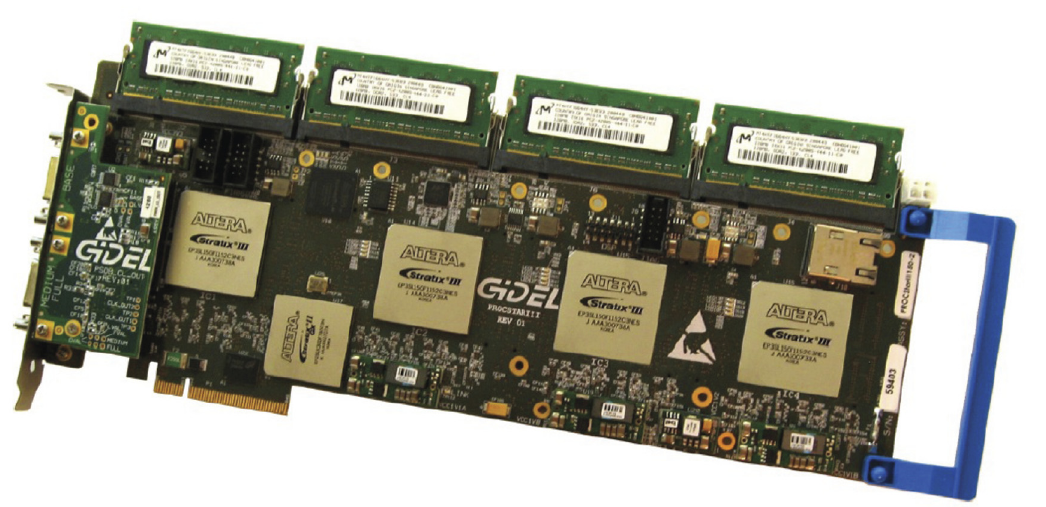
Fig 12. FPGA-based PCIe board used for the data mining process from GIDEL.